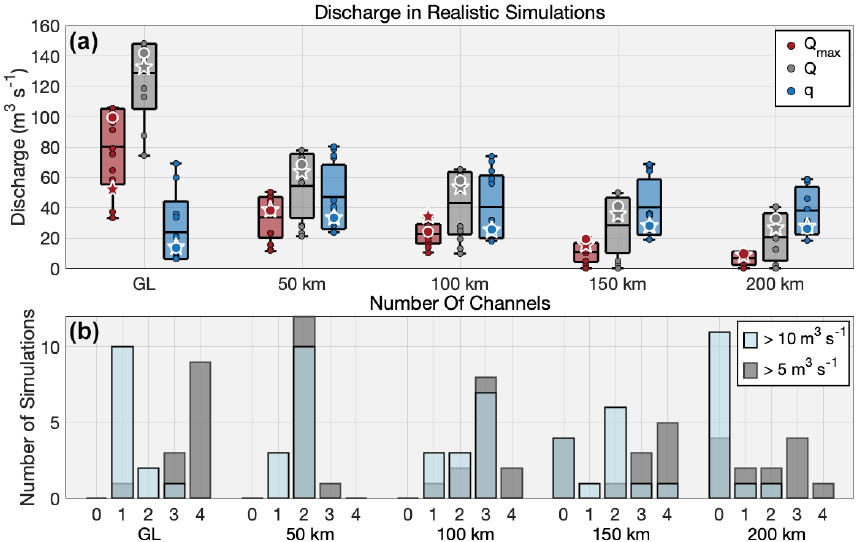
Figure 6. (a) Total distributed (blue) and channel discharge (gray), as well as the discharge of the largest channel (red), across each transect (see Fig. 5) for all data-compatible FSS runs (circles). Boxplots indicate the maximum, minimum, mean, and standard deviations. The stars indicate the high-resolution model, and the white-edged circles designate its low-resolution counterpart. (b) The number of channels with